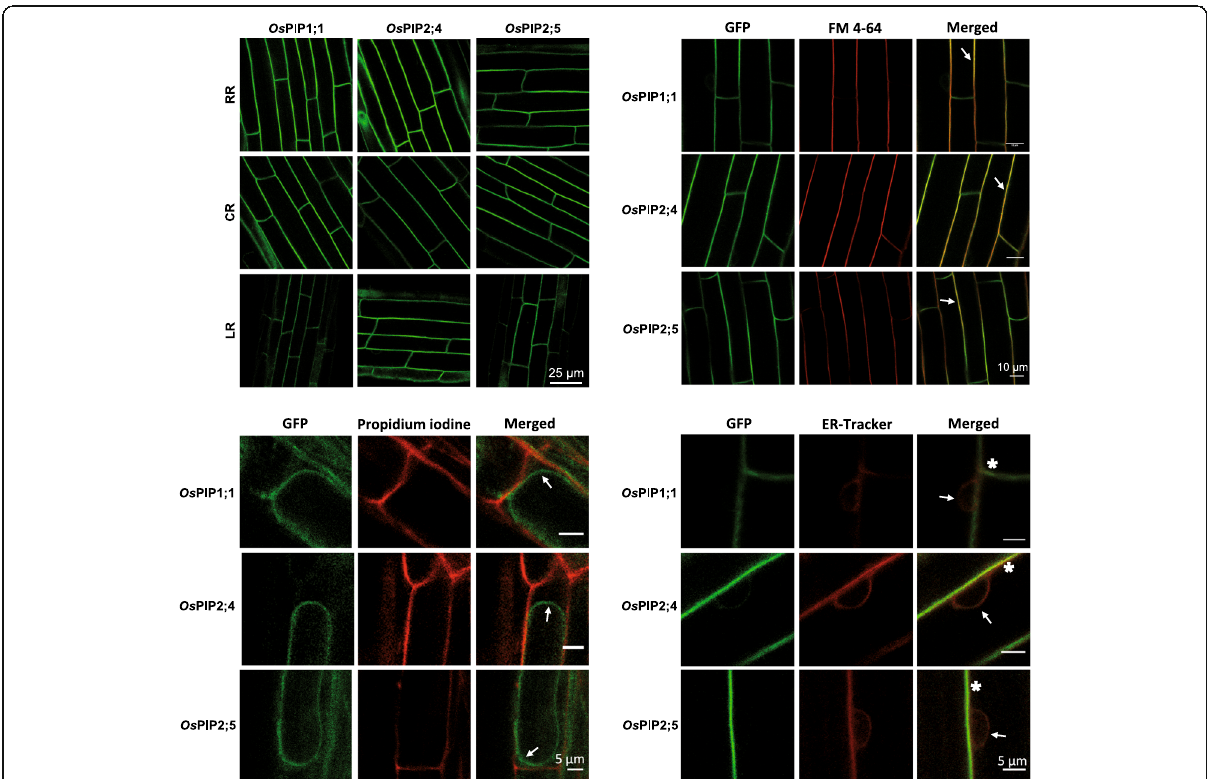
Fig. 1 Subcellular localization of PM protein markers tagged with fluorescent proteins in rice root. Labelling of Os PIP-GFP constructions was observed in exodermis of fresh roots in different types (upper left). Each row of photos refers to distinct types: RR, radicle root; CR, crown root; LR, lateral root. Root cells were briefly stained with FM4 – 64, a typical PM-dye in these conditions, and showed a colocalization with Os PIP-GFP signal (arrows, upper right). Plasmolysis of protoplasts was observed with propidium iodide counterstaining the cell wall, and did not show any colocalization with Os PIP-GFP signal (arrows, lower left). ER-Tracker Blue-White DPX stained a compartment surrounding the nucleus, tentatively identified as endoplasmic reticulum (arrows, lower right). Due to limited resolution of light microscopy, PM and endoplasmic reticulum labelling could not be separated properly (asterisks). Root cells were observed by means of laser scanning confocal microscopy. Images were taken at a region ~0.5 – 1 cm from the root tip of plants, 7 – 8 days after